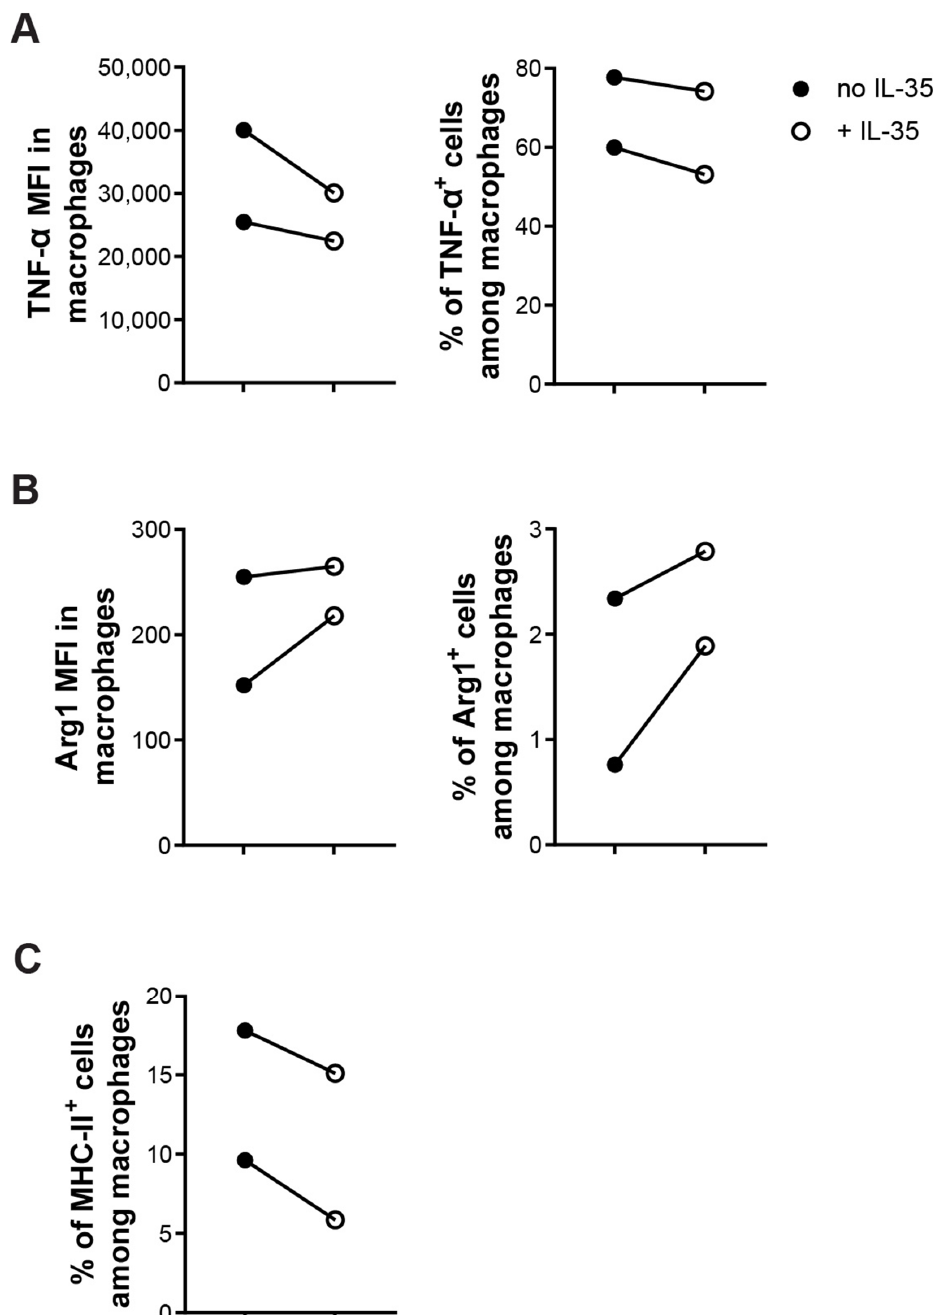
Figure 7. IL-35 treatment effects directly on macrophages to lowered M1/M2 ration in vitro. Sorted CD11b + F4/80 + macrophages were created with LPS with or without recombinant IL-35 (10 ng/mL) for 24 h in a 96-well plate. Harvested cells were stained and cells were analyzed by flow cytometry. ( A ) MFI of TNF- α among macrophages and percentage of TNF- α + cells among macrophages. ( B ) MFI of Arg1 among macrophages and percentage of Arg1 + cells among macrophages. ( C ) Percentage of MHC ‐ II + cells among macrophages. Each experiment was repeated twice. Paired t ‐ tests were performed for comparisons. Similar to macrophages, pDCs are also increased in the early stage of T1D develop ‐